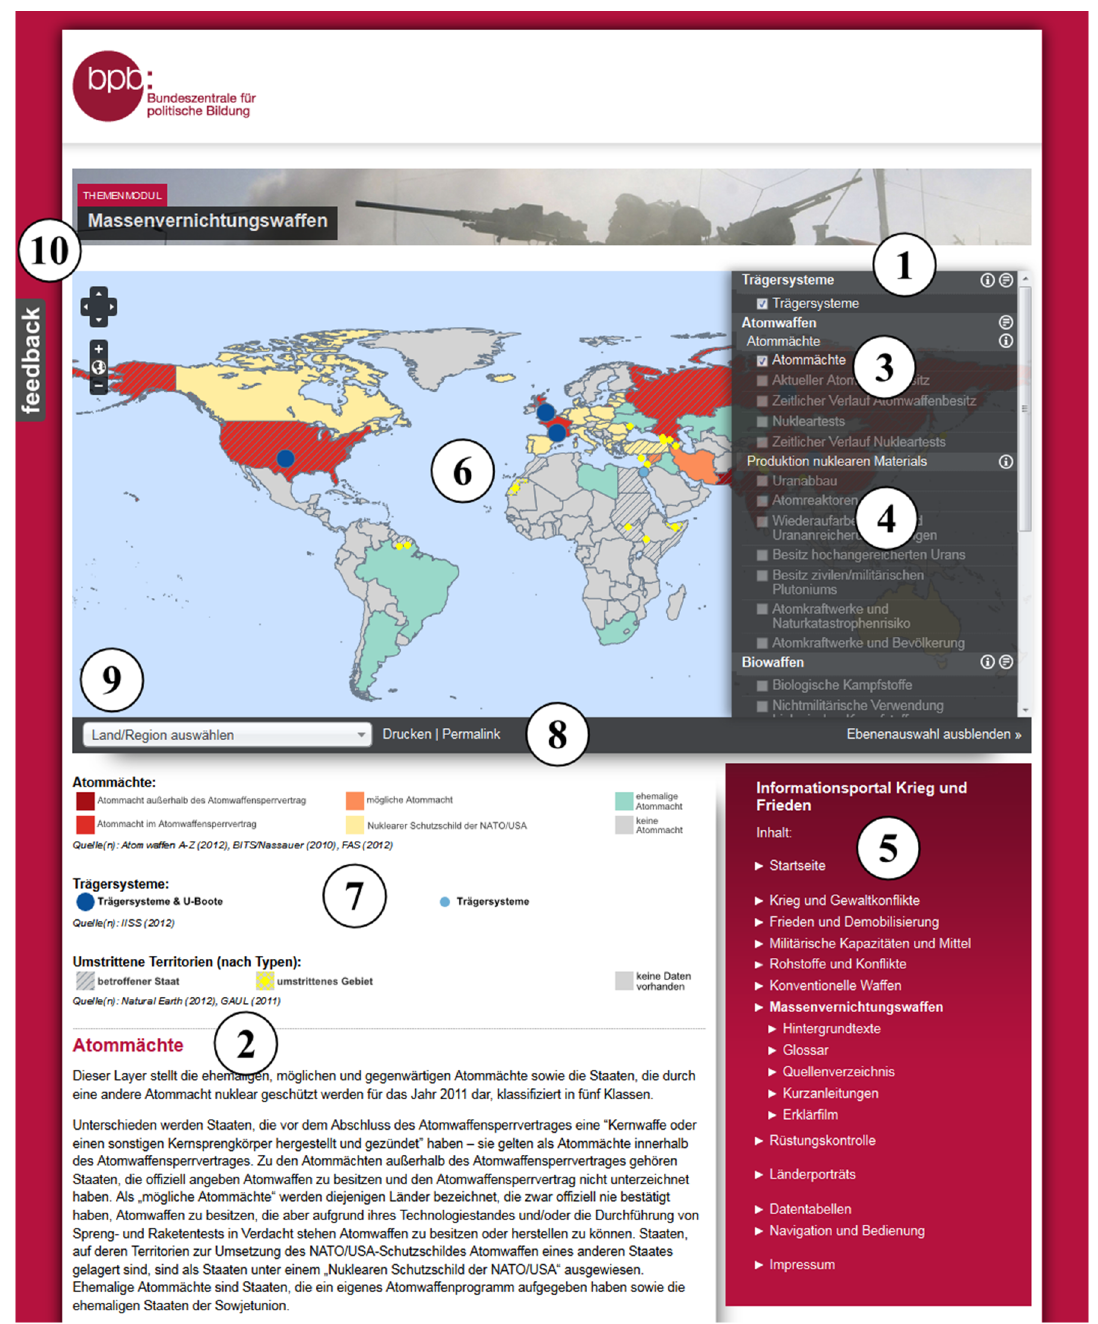
Figure 3. Screenshot—Thematic module weapons of mass